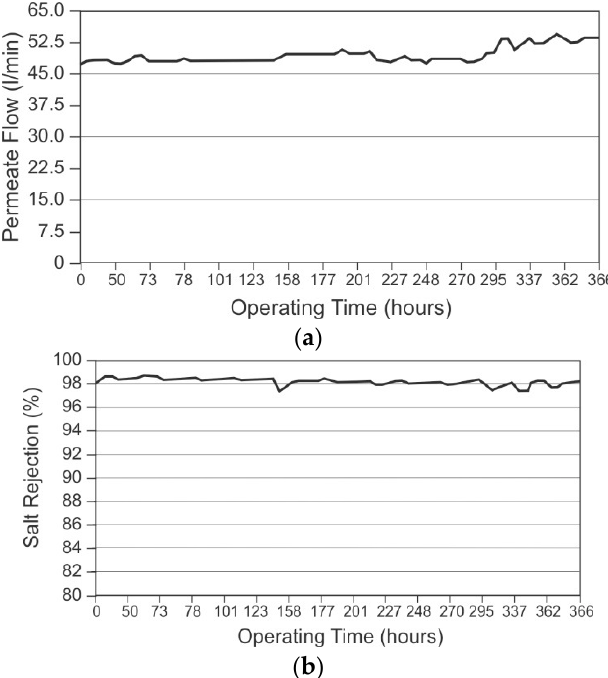
Figure 23. Normalized permeate flow ( a ) and normalized salt rejection ( b ) as a function of operating time for a polyamide seawater membrane operating on BCDMH biocide dosing. Conditions: feed water: Atlantic Ocean at St. Croix, United States Virgin Islands; feed pressure: 57 bar; system recovery: 43%; membrane: Koch Membrane Systems 2822SS; BCDMH dosing: 4-h intervals (dosage concentration was not provided) Obtained from patent application US 20060032823 A1 [371].